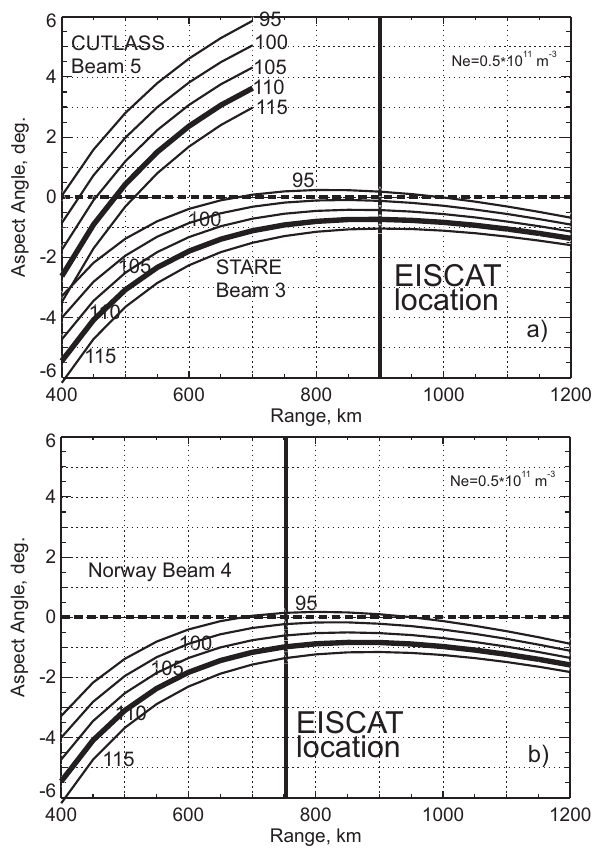
Fig. 6. Aspect angles versus slant range at various heights for (a) Norway STARE radar beam 4, (b) Finland STARE radar beam 3 and Hankasalmi CUTLASS radar beam 5. An electron density of 5 × 10 11 m − 3 was assumed.